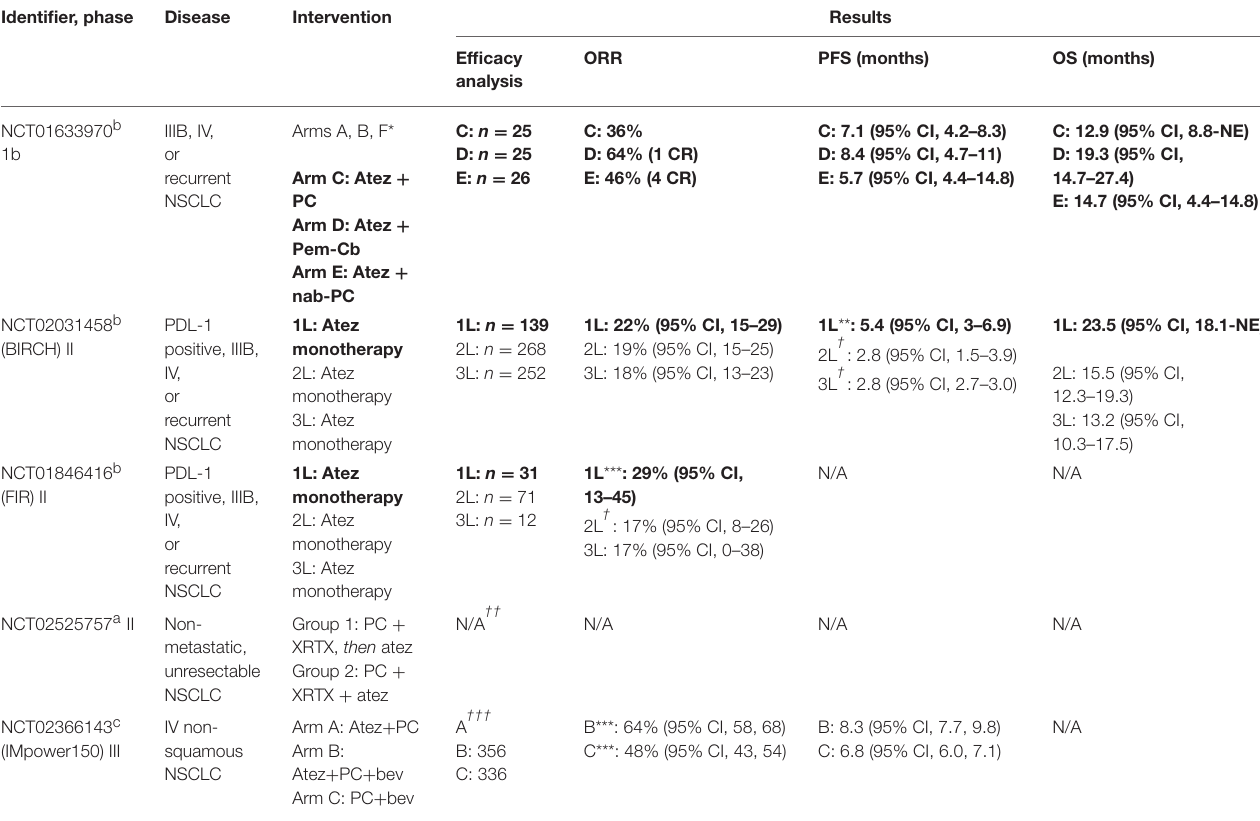
TABLE 1 | Current trials with results. Identifier, phase Disease Intervention Results